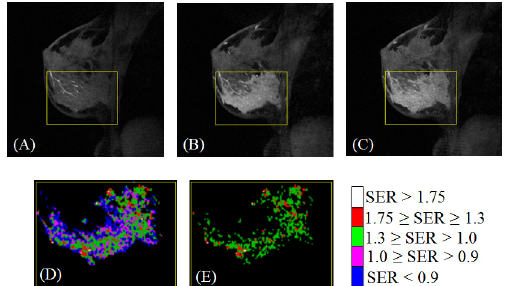
Fig 3. Representative clinical case showing the effect of changing PE t and SER t in FTV calculation. (A) − (C): representative baseline MR images of breast cancer. Yellow rectangular indicates tumor ROI. (A) was acquired before contrast injection. (B) and (C) were at the same slice location as in (A) but was acquired at the early and late enhancement time points after contrast injection. (D) and (E) show voxels selected within the ROI using different PE t / SER t combinations. SER colormap is shown on the right of (E). (D) PE t = 70%, SER t = 0, FTV = 43.4 cc. (E) PE t = 100%, SER t = 1.0, FTV = 20.6